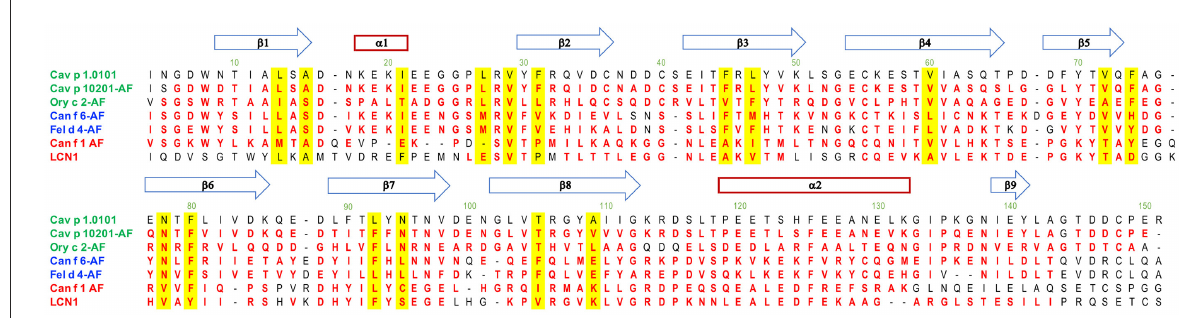
FIGURE10 Alignment of lipocalin models with the Cav p 1.0101 structure. Residues structurally aligned with a 2 Å cutoff in PyMol are shown in red. The blue arrows and red rectangle define secondary structures of Cav p 1.0101. Residues with their sidechain contributing to the cavity are highlighted in yellow. Allergen structures with the acronym AF were predicted with AlphaFold v2.0.